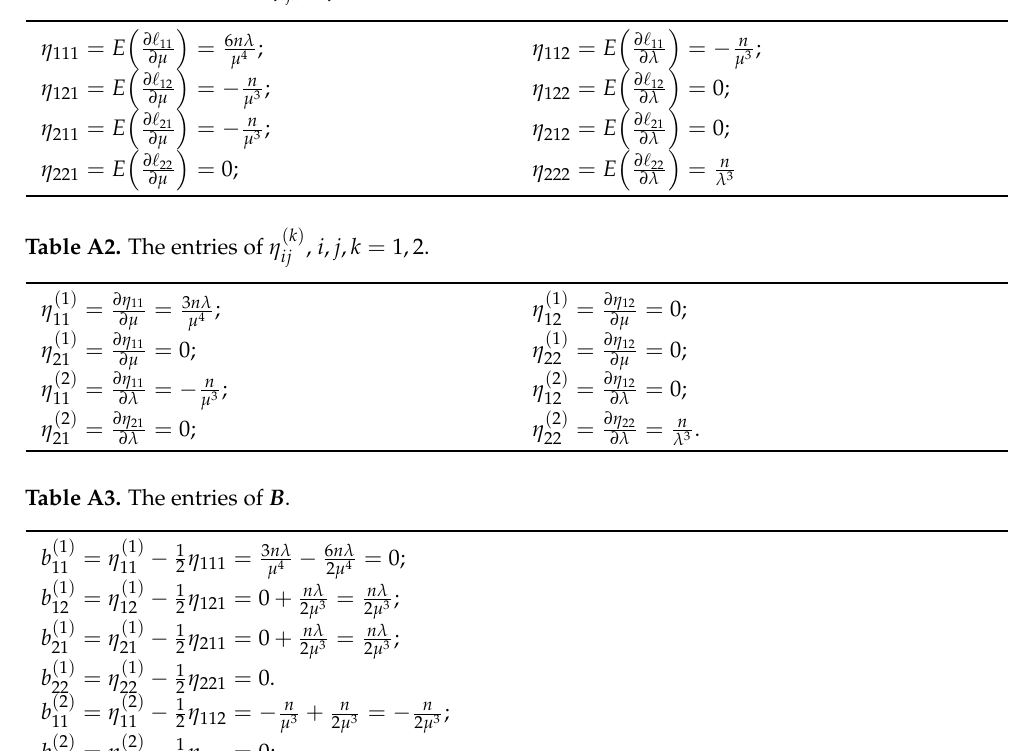
Table A1. The entries of η ijk , i , j , k = 1,2.